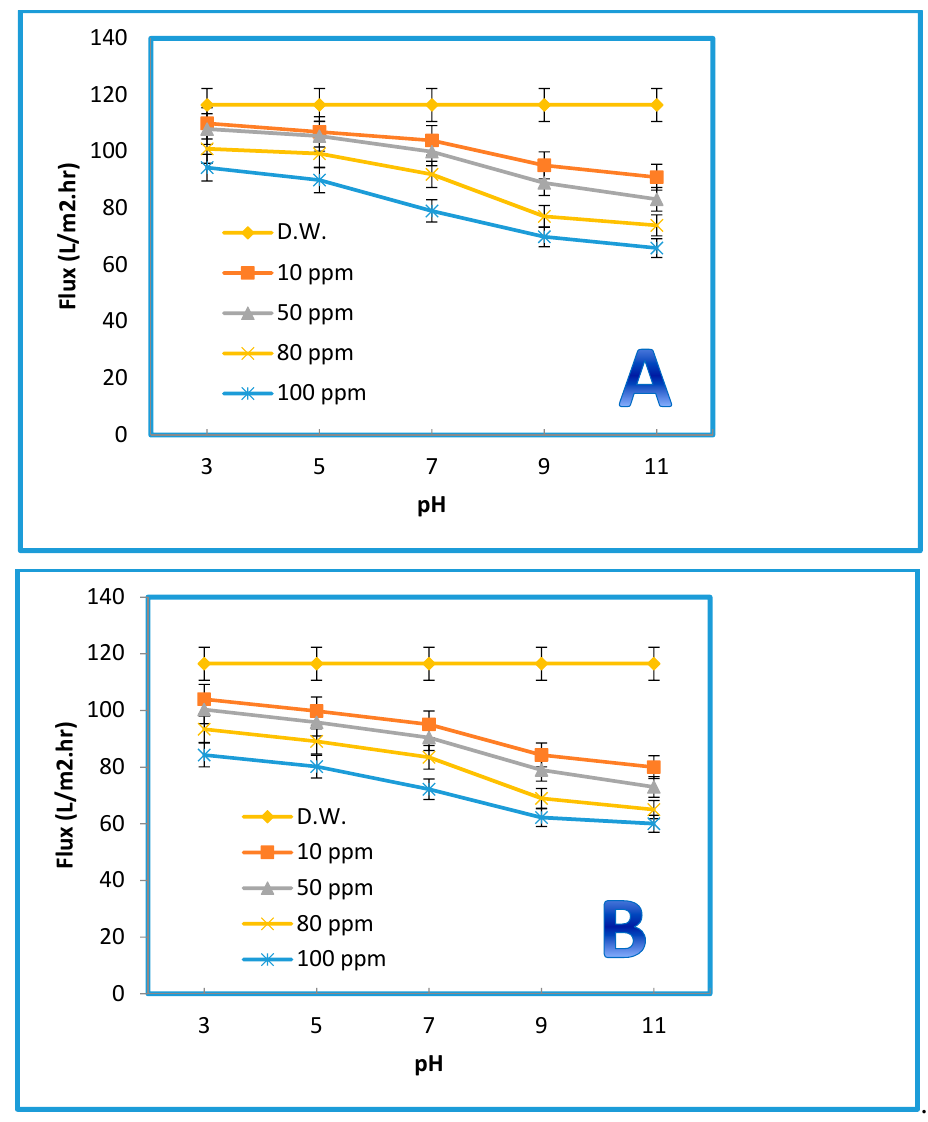
Figure 12. Effect of pH on the permeation flux of membrane prepared from % 0.5 GO, at 3 bar, 25 °C, for Acid Black (AB-210) ( A ) and Rose Bengal (RB) ( B ) .